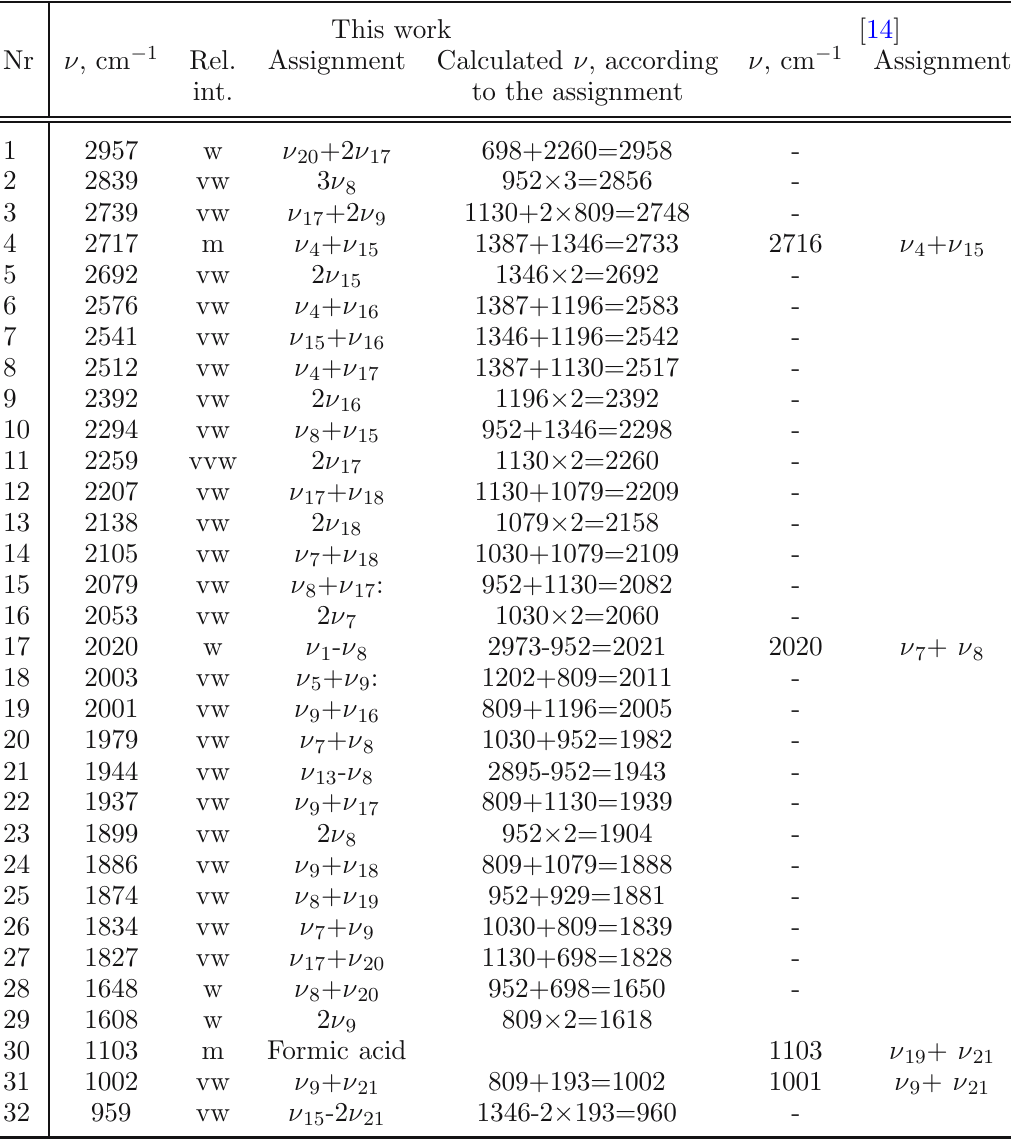
Table 2 The experimental combination and overtone spectral bands of ethene secondary ozonide and their